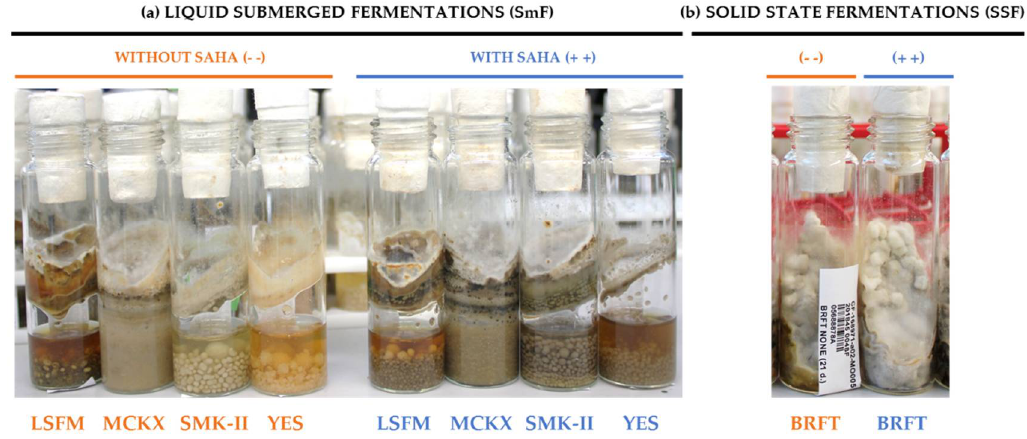
Figure 1. Example of Parastagonospora sp. CF-168971 showing different morphologies when grown in 10 fermentation conditions. ( a ) Fungal strain grown in liquid submerged fermentations (SmF) in four media LSFM, MCKX, SMK-II and YES without SAHA (- -) (four EPA vials on the left) and supplemented with SAHA (++) (four EPA vials on the right) after 14 days of incubation. ( b ) Fungal strain grown on solid-state fermentation (SSF) in BRFT medium without SAHA (- -) (EPA vial on the left) and with SAHA (++) (EPA vial on the right) after 21 days of incubation.